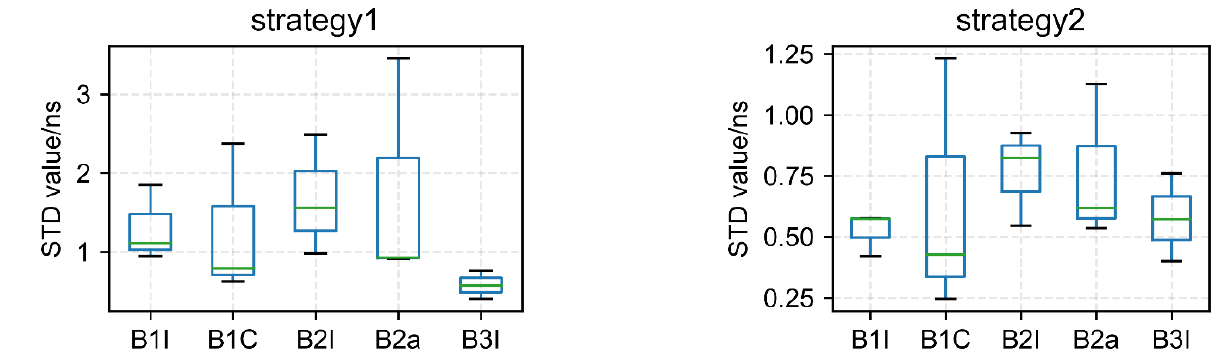
Figure 11. The average STD of clock difference of three stations with two strategies for different frequency points.